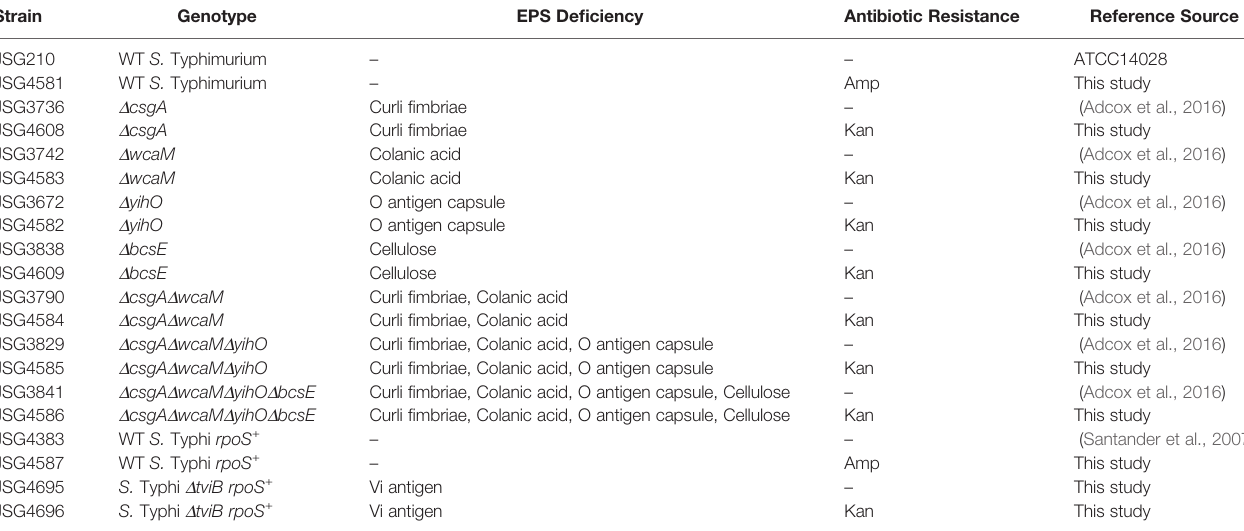
TABLE 1 | Wild-type (WT) and extracellular polymeric substance (EPS) mutant strains used for this study.